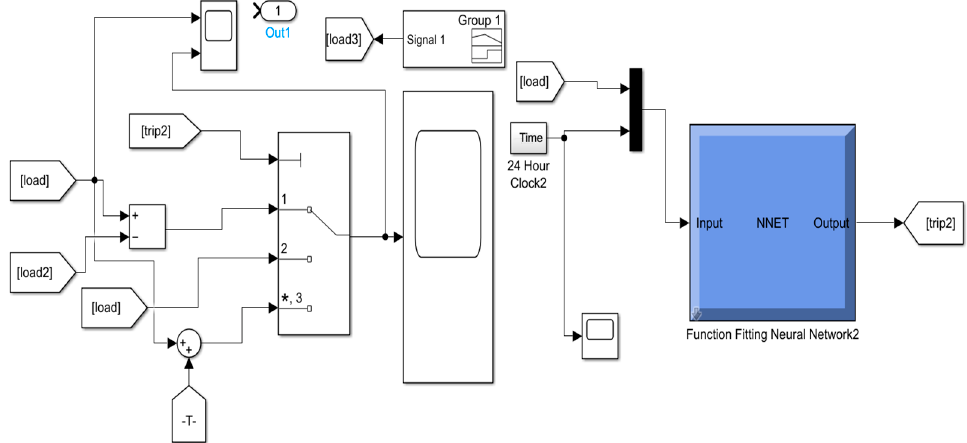
Figure 8. Simulink energy management model through load shifting (LS) using a neural network.